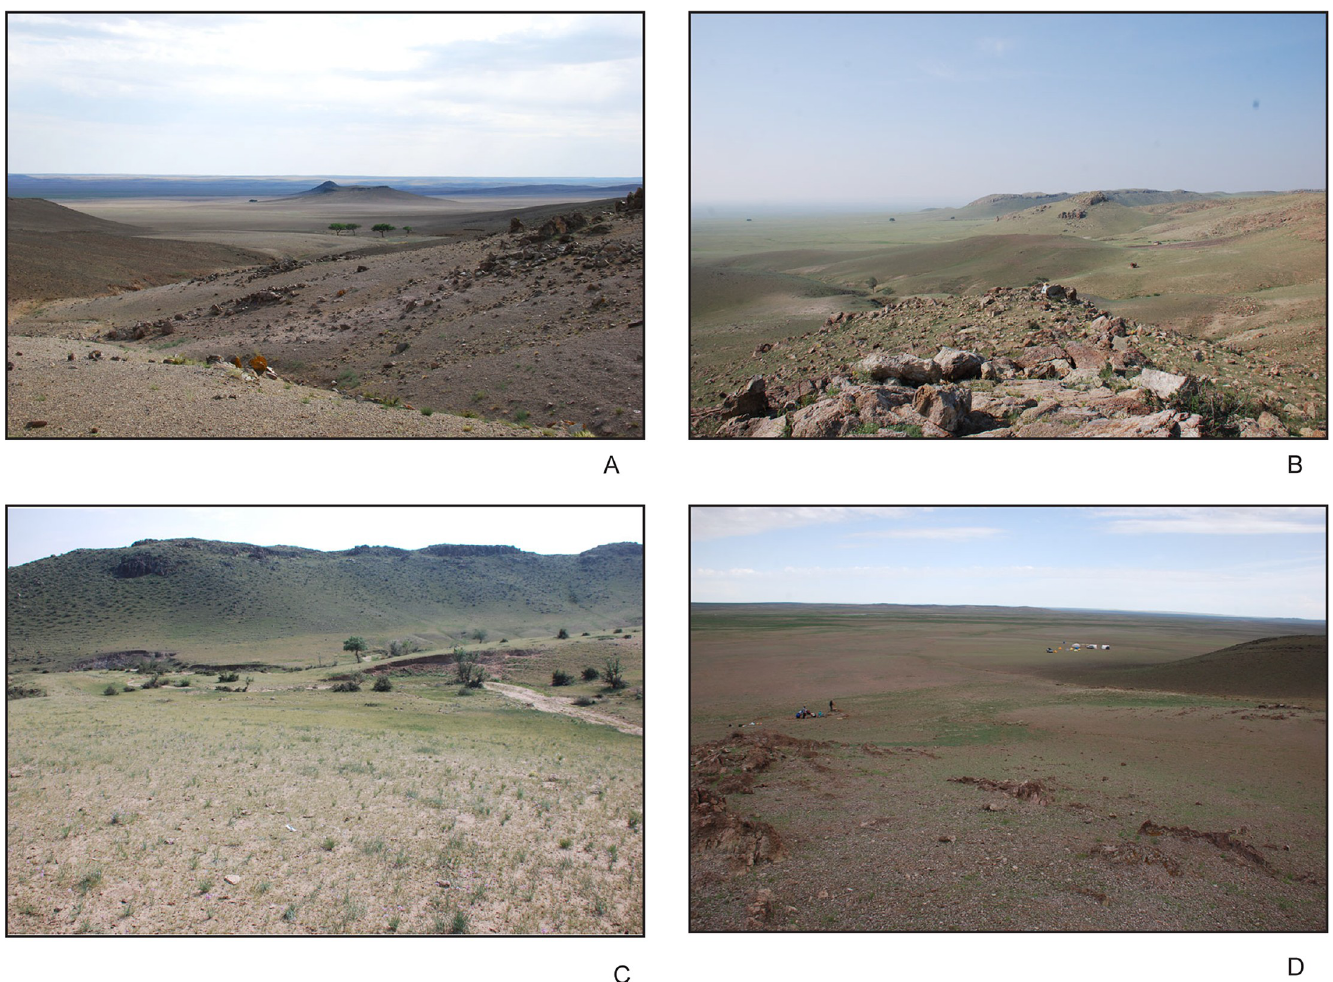
Fig 4. Landform morphology across different sections of the basin: (A) view of basin from Otson Tsokhio, (B) view of basin and ranges looking towards Zaraa Uul from Zuun Shovkh, (C) view of landscape around stream sampled for GEO-ZU1, and (D) overlooking Zaraa Uul loci from the saddle of hill with the extinct volcano in the upper right of